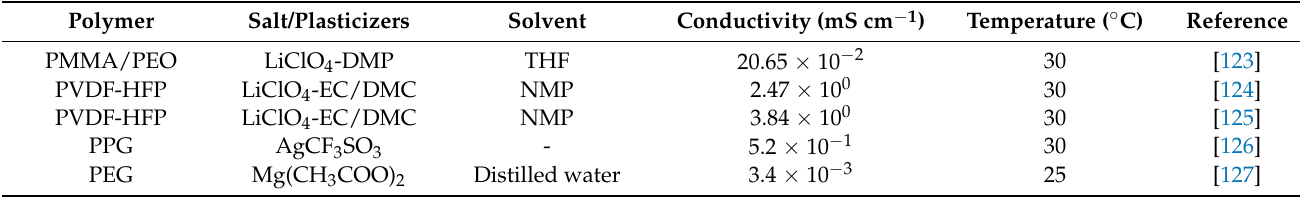
Table 5. List of GPEs with CeO 2 filler with their conductivity and